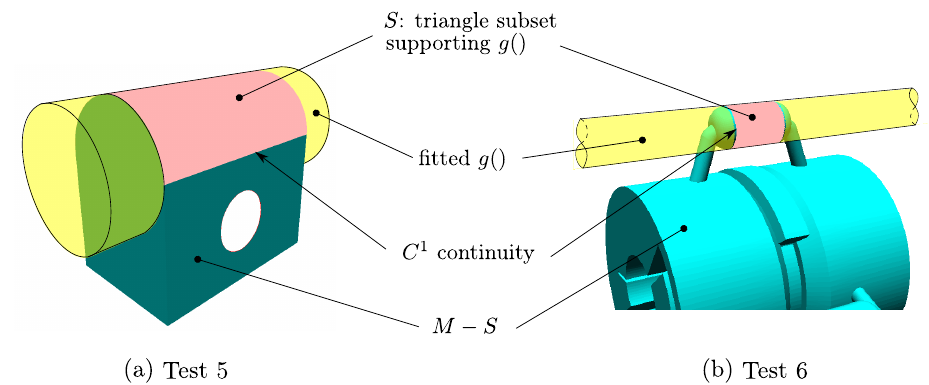
Figure 20. Cylinder fit. Fitting-based S extraction. Pink: extracted S support subset. Yellow: fitted g () . Cylinder. Fitting performance Table 6. Cylinder fit. Set vs. found parameters. Tests 1–4: S extraction based on dihedral angles. Tests 5–6: Fitting-based S